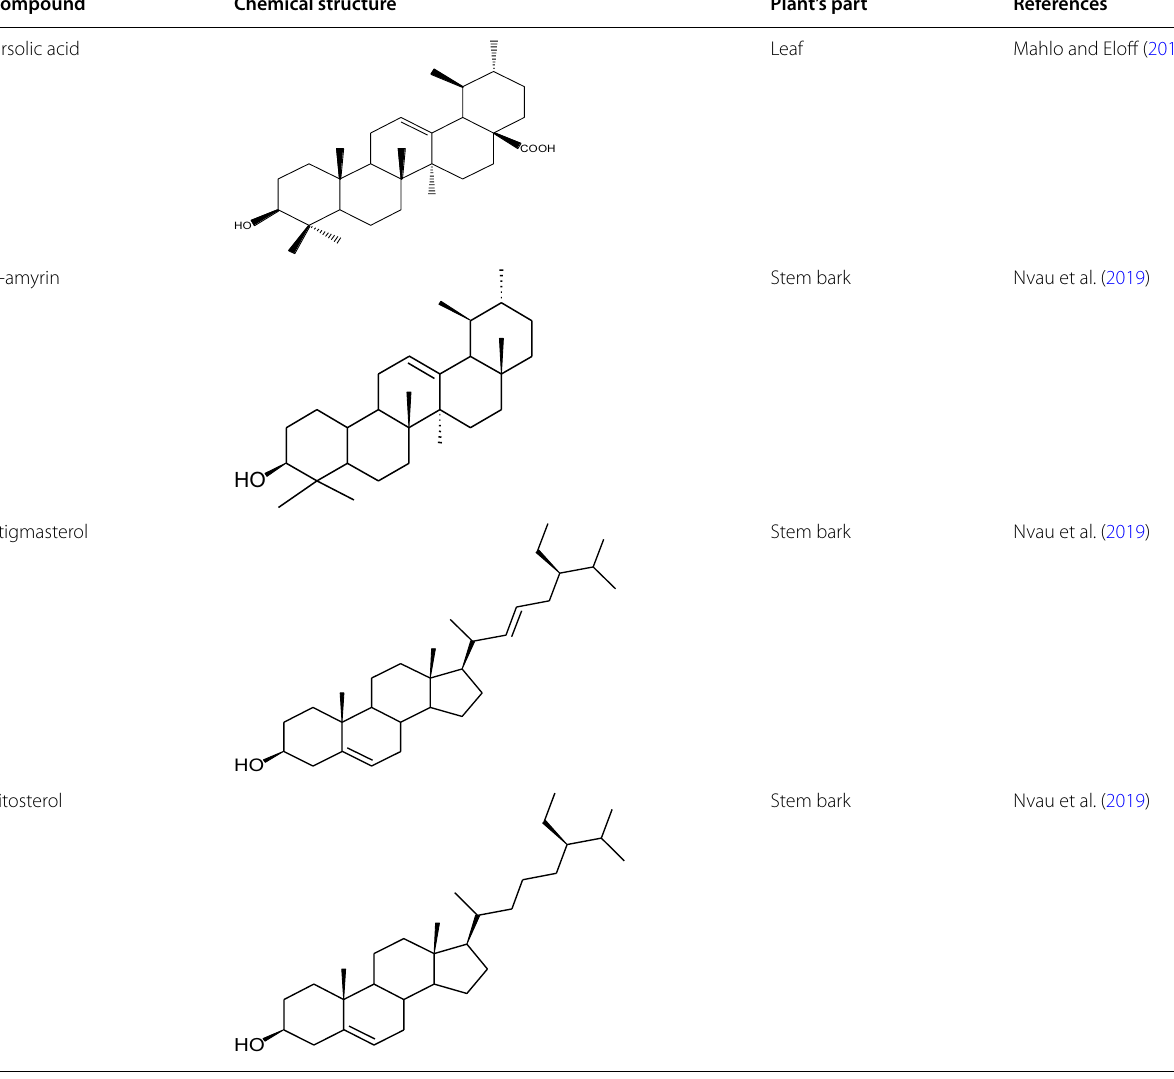
Table 1 Terpenes and sterols isolated from Breonadia salicina Compound Chemical